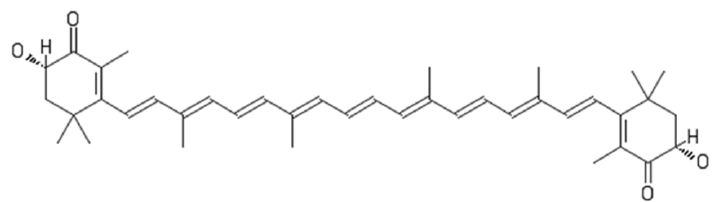
Figure 4. Chemical structure of astaxanthin.